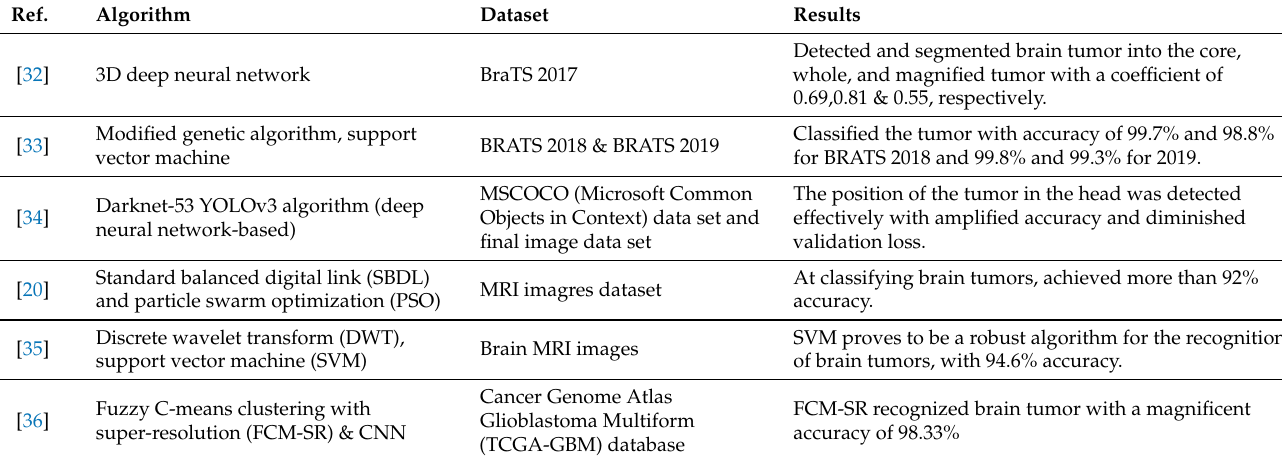
Table 1. Prediction algorithm as applied in